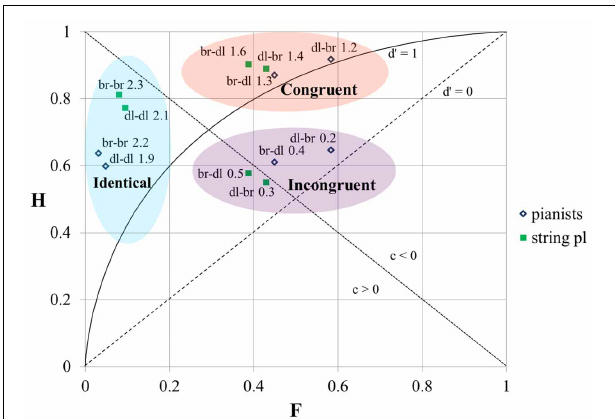
FIGURE 3 | The results of the SDT analysis of the responses of pianists and string players at different timbral orders of stimuli. H, “hit” rate; F, “false alarm” rate; br, bright timbre; dl, dull timbre; the numbers on the graph correspond to d (cid:2) -values. For the diagonals and the bowed curve see explanation in the